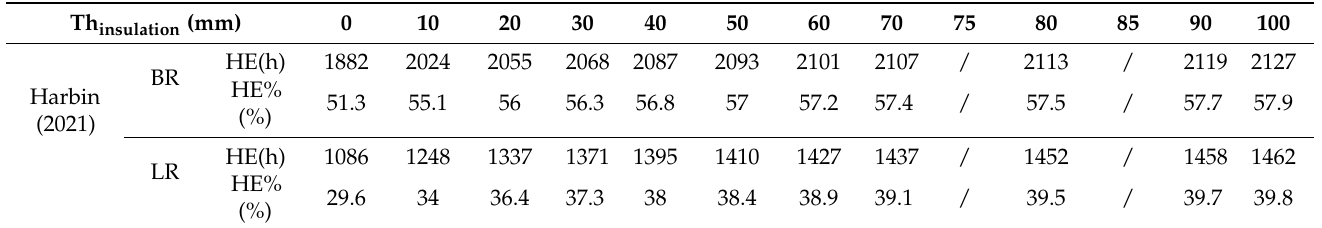
Table 10. Overheating duration with Th insulation as variable in the simulated flats (on the 7th floor) of Harbin from May to September of 2021.